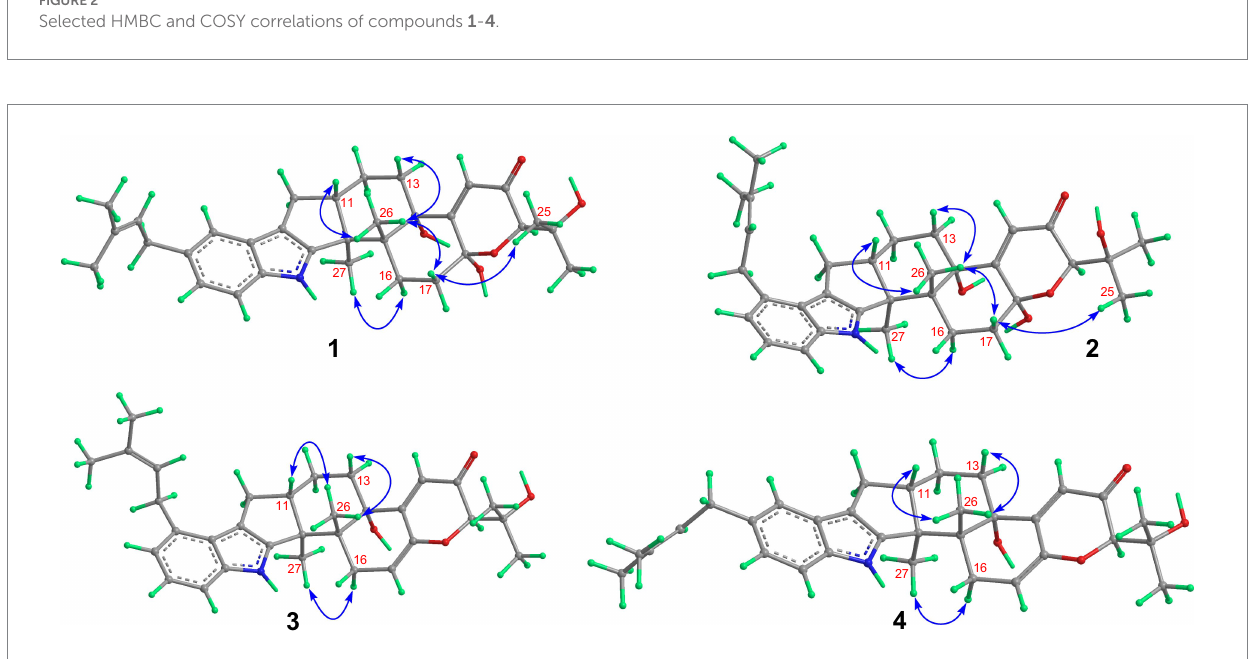
FIGURE 3 Selected ROESY correlations of compounds 1 - 4